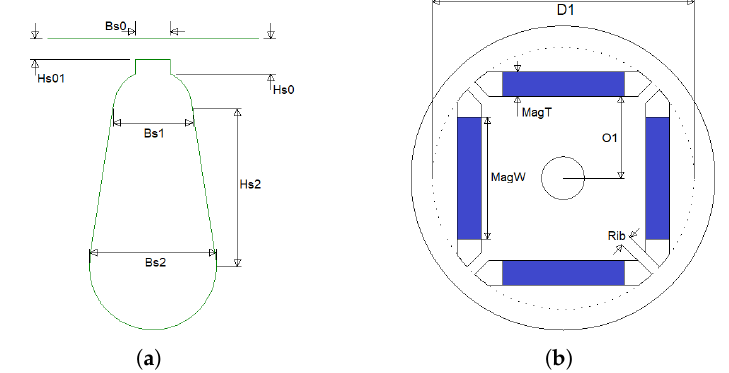
Figure 24. Parameters to be varied during optimization: ( a ) available slot parameters, ( b ) available magnet